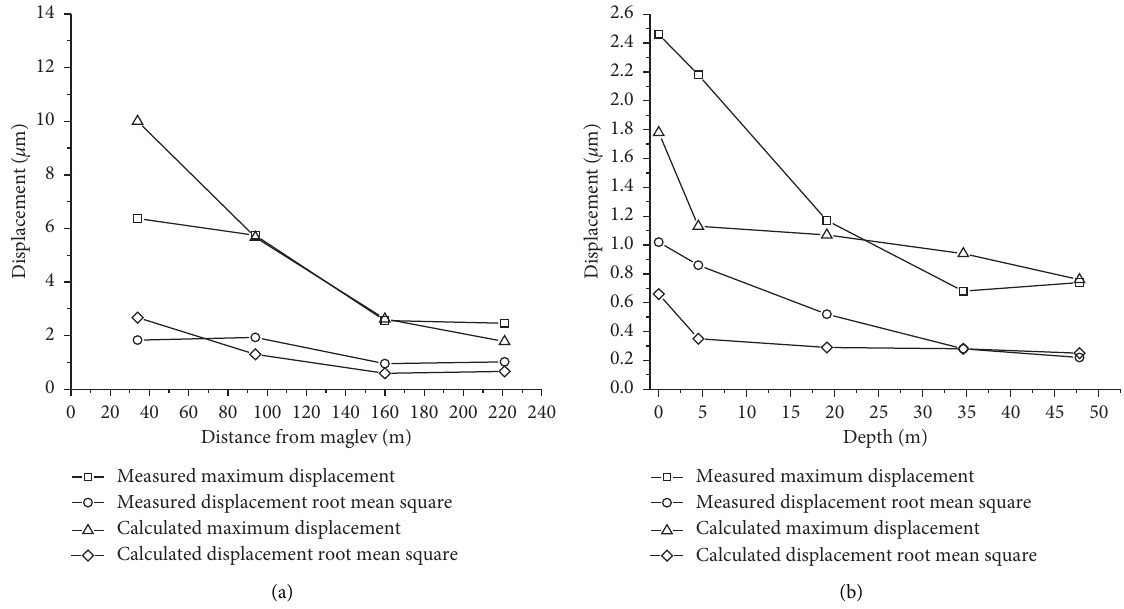
Figure 25: Comparison of numerical and field results: relationships between vibration displacement and (a) distance of surface measuring points from maglev (GII-5–GII-8) and (b) the measuring points varying with depth